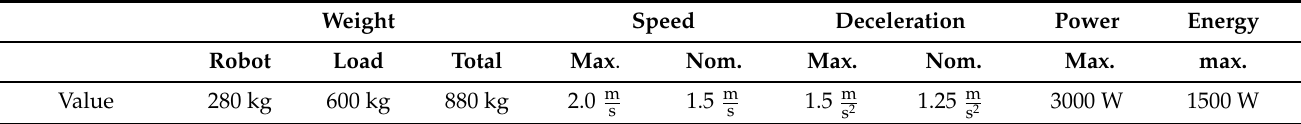
Table 2. Specifications of the considered